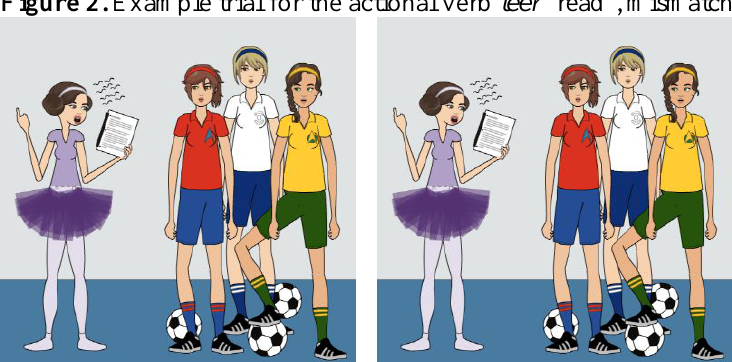
Source: Image created by author using Pixton Comics© Figure 3. Example trial for the psych verb gustar ‘like’, match condition